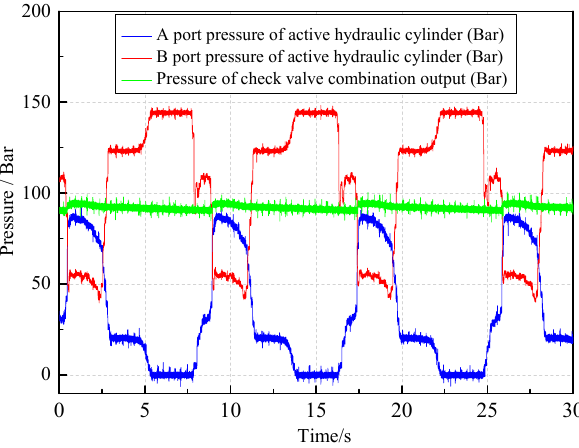
Figure 12. Pressure curves of active hydraulic cylinder and check valve.